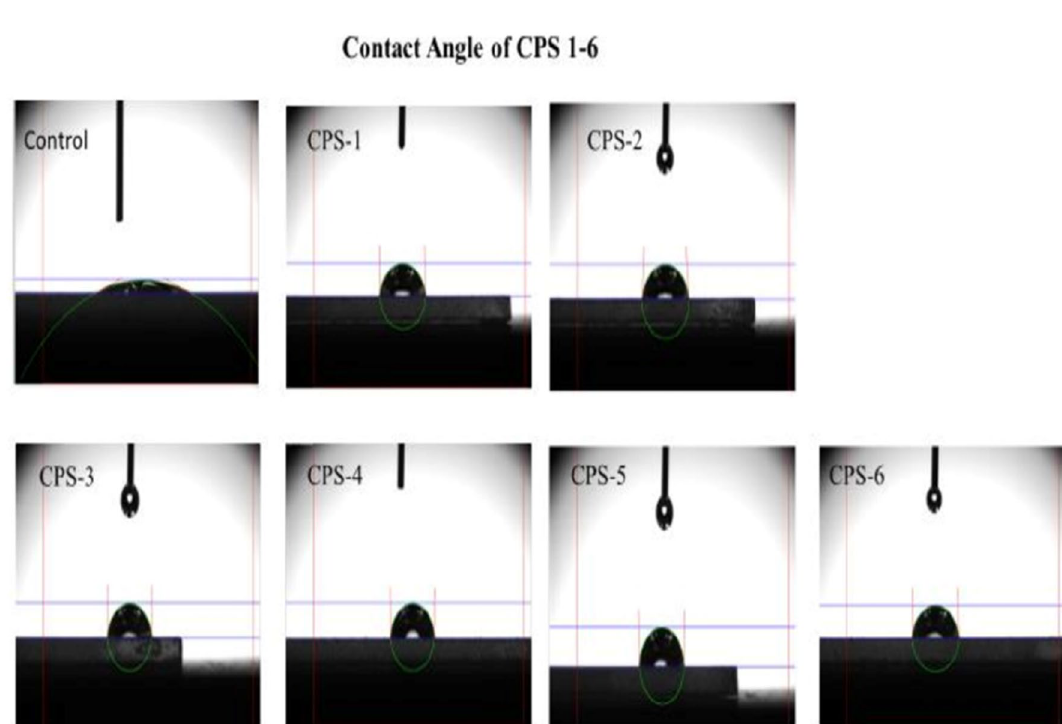
Figure 8. Contact angle of coated